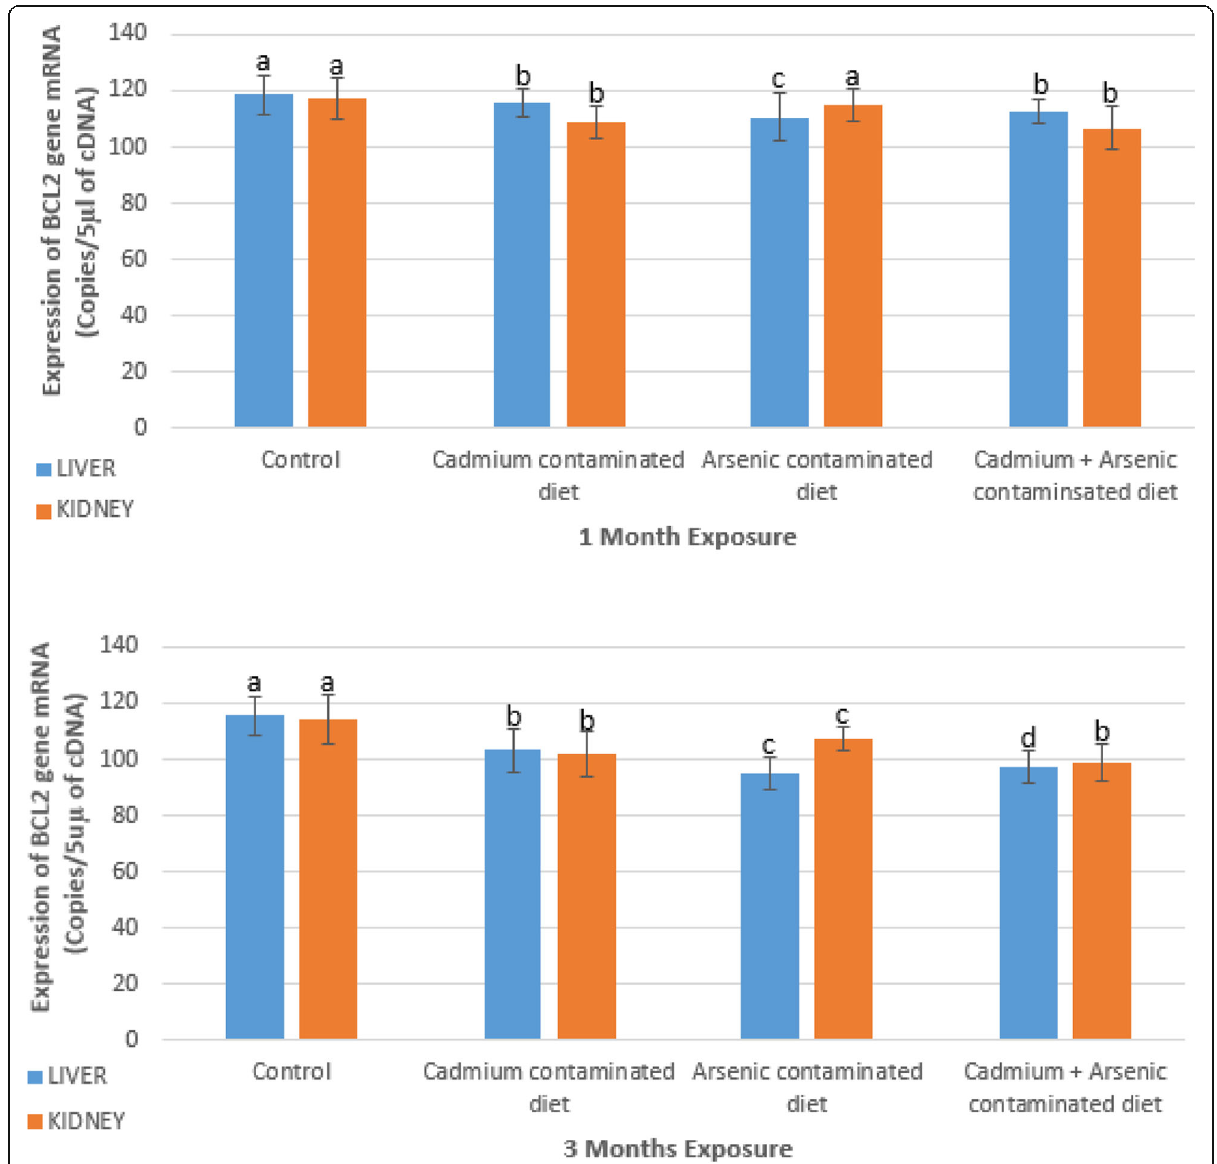
Fig. 4 Changes in the expression of Bcl2 gene mRNA in the liver and kidney of rats after 1- and 3-month exposures to experimental diet. Values not sharing the same superscript within a tissue differ significantly at P <